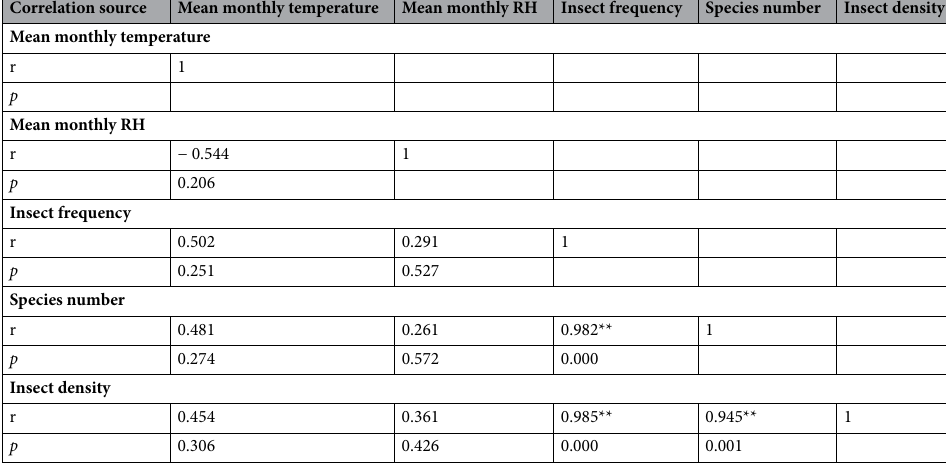
Table 5. Correlation between the species of Cerambycidae family and environmental factors. ** Correlation is significant at 0.01. r: Correlation coefficient p : Significance level, r: 0.00 No correlation, 0.01–0.29 Low-level